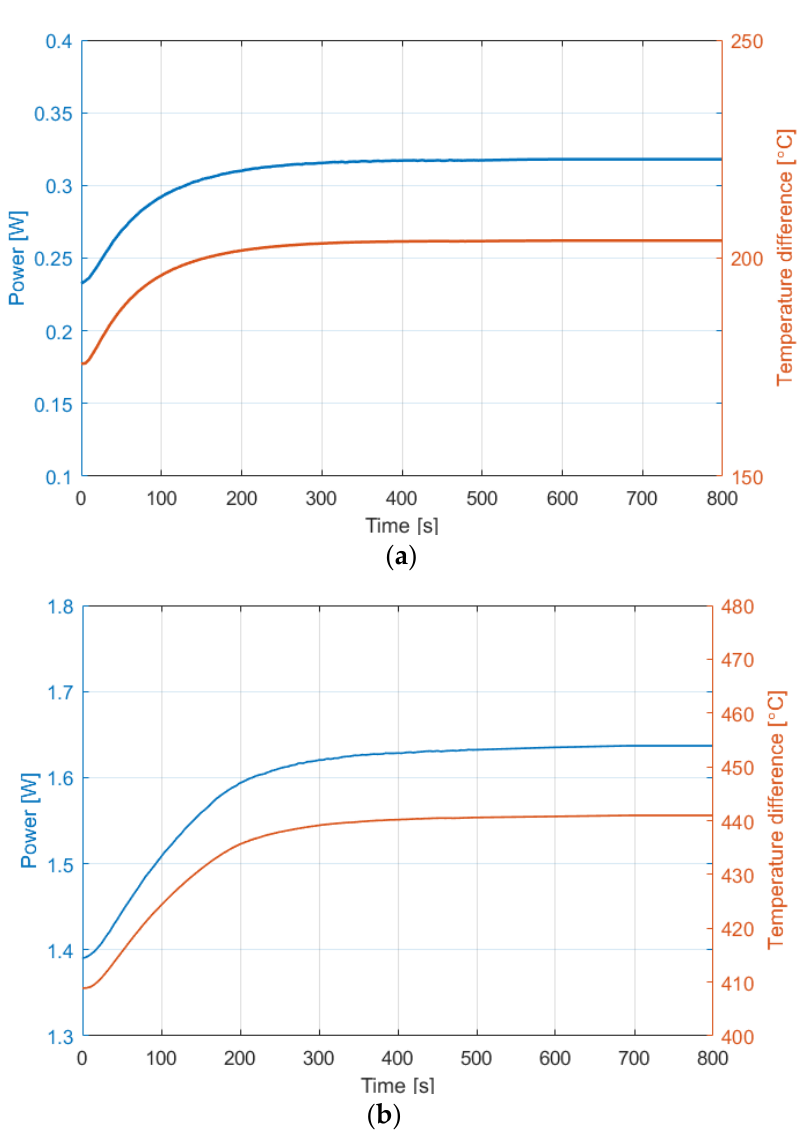
Figure 7. Power and temperature difference transient response at with T ref,step = 50 °C at ( a ) T ref_end = 400 °C; and ( b ) T ref_end = 800 °C.